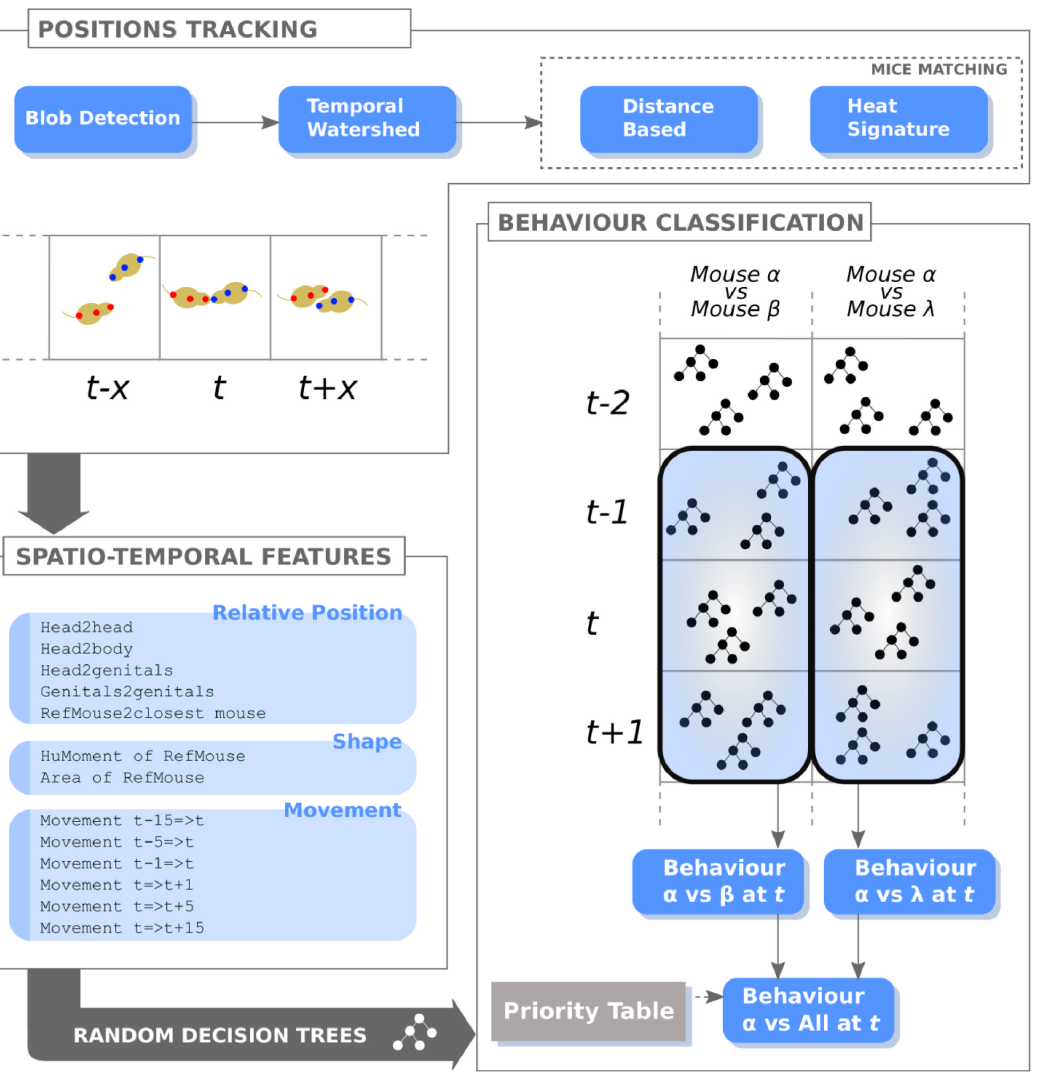
Figure 2. Algorithm diagram summarizing the behaviour classification phases. The ‘‘Position Tracking’’ is composed of a pipeline of three modules. The blob detection module initialises the system, estimates the foreground shapes (i.e. it locates possible mice), and filters out unfeasible structures; the temporal watershed module identifies mouse positions and shapes, and their directionality; the mice matching module tracks the identities of each mouse. Then, a feature vector composed of 13 measurements describes relative position, movement and attitude of mice for all possible pairs. Finally, the continuous action description for the mice is generated thanks to our Temporal Random Forest approach, which evaluates ensembles of decision trees through